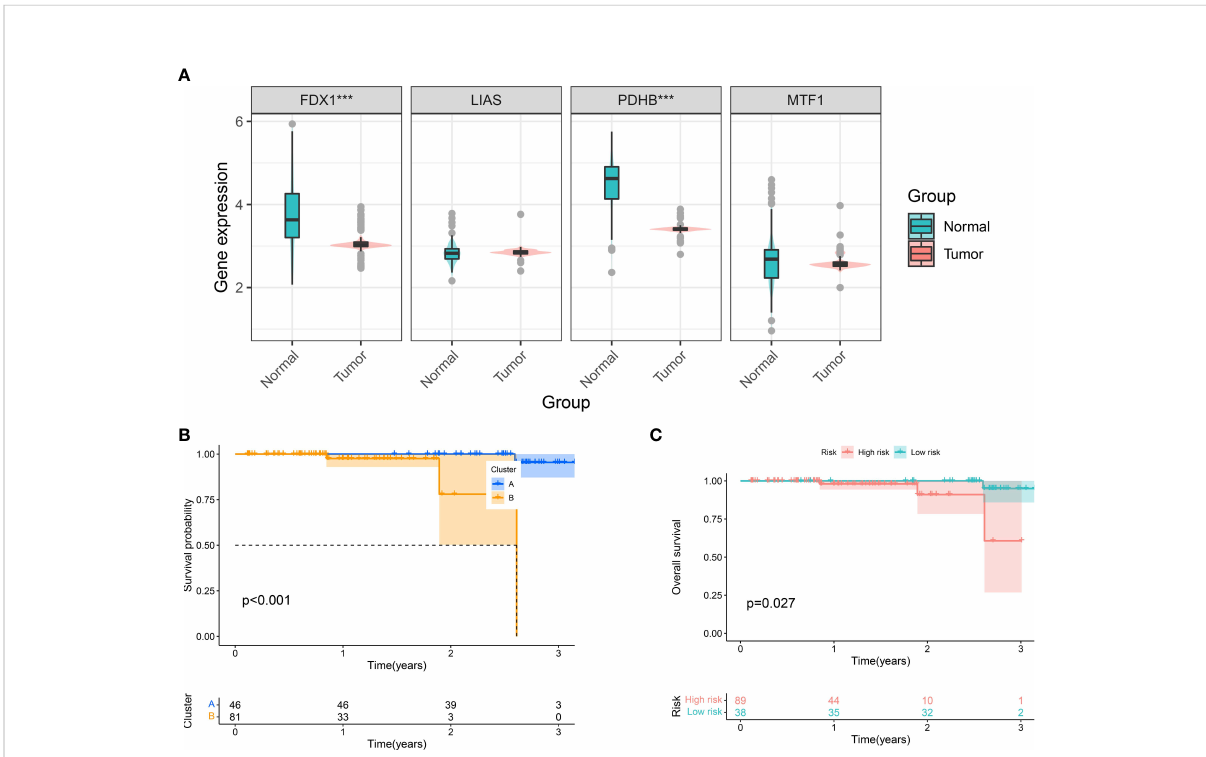
FIGURE 6 Clinical Validation of Cuproptosis Phenotypes and CuproScore. (A) Differential expression of FDX1, LIAS, PDHB, and MFT1 in Taizhou cohort. Kaplan-Meier Curves for differential survival of two cuproptosis phenotypes (B) and two risk groups (C) in Taizhou cohort. ***P<